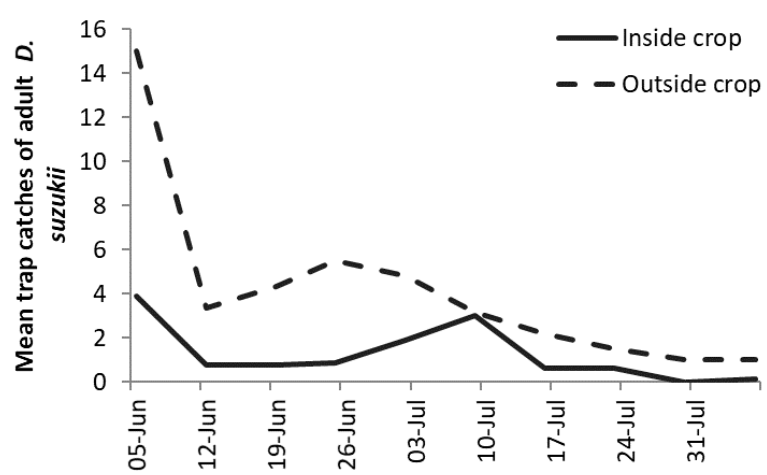
Figure 3. Combined mean trap catches of D. suzukii inside and outside exclusion netting during the 2018 field trial.